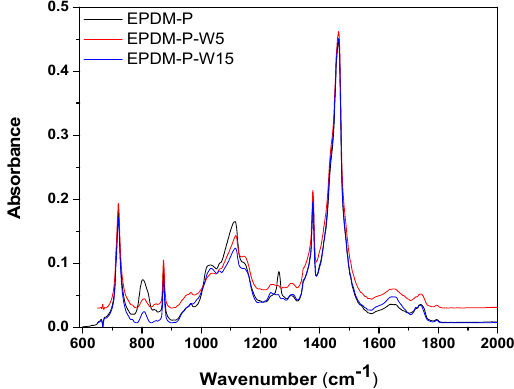
Figure 8. FTIR spectra of EPDM-S composites cross-linked by peroxide (P).